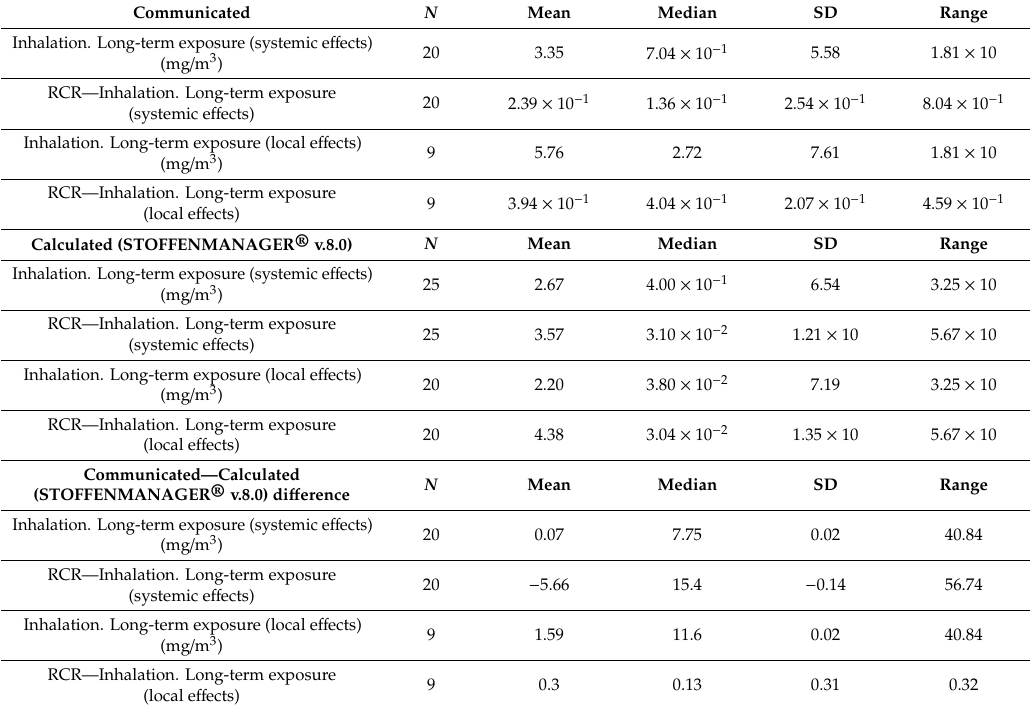
Table 10. Comparison and di ff erence between communicated exposure estimates and calculated exposure estimates with STOFFENMANAGER ® v.8.0 with associated RCRs. N: number of valid exposure estimates. SD: standard deviation.